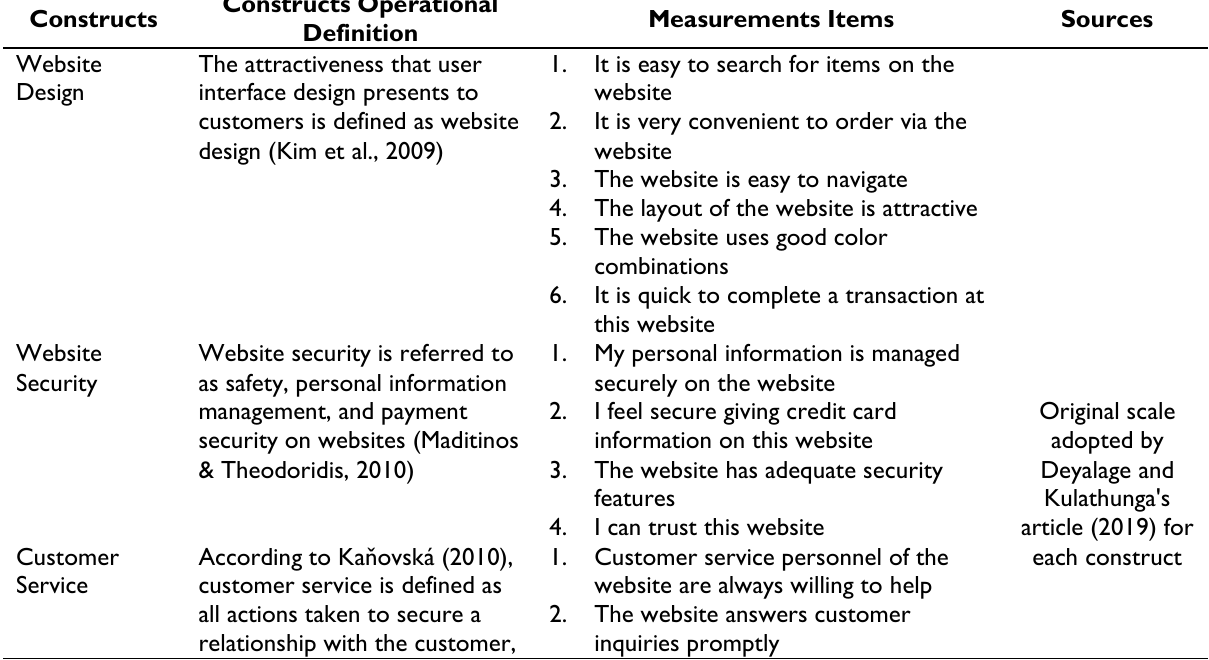
Table 1: Measurement of Constructs